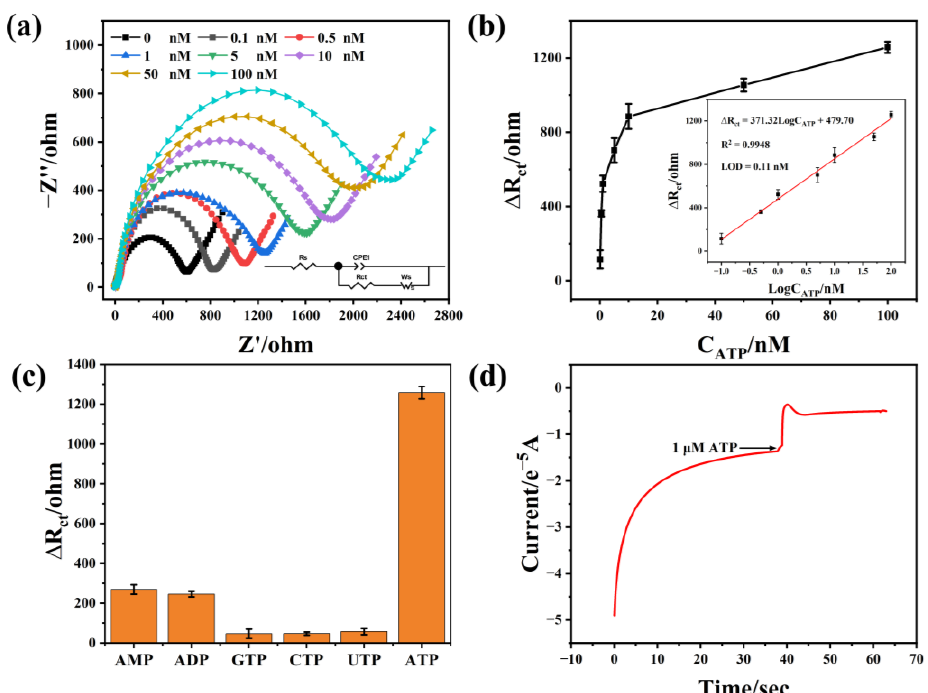
Figure 4. ( a ) EIS Nyquist plots for the detection of different concentrations of ATP (0, 0.1, 0.5, 1, 5, 10, 50 and 100 nM) (inset: the equivalent circuit model for EIS fitting); ( b ) the corresponding calibration curves between ΔR ct and ATP concentrations (Inset: the linear calibration curve for ATP determination); ( c ) selectivity study of the aptasensor; ( d ) I – T curves or kinetics test.